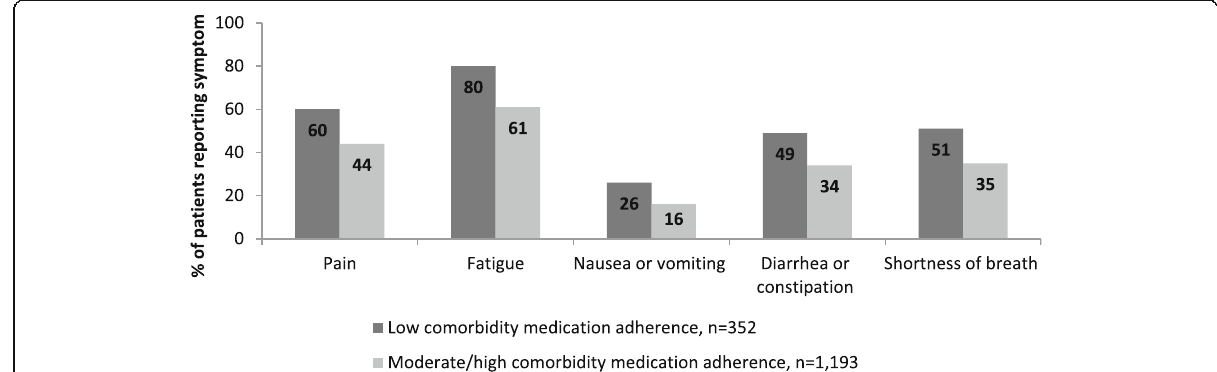
Fig. 2 Patient-reported cancer-related symptoms by comorbidity medication adherence . Morisky Medication Adherence Score < 6 was defined as low comorbidity medication adherence. Morisky Medication Adherence Score = 6, 7 or 8 was defined as moderate/high medication adherence. All comparisons significant at the P < 0.001 level by chi-square test